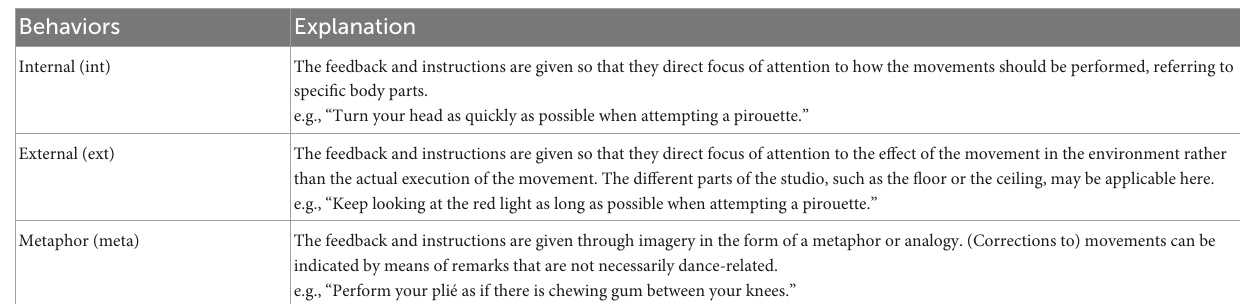
TABLE 2 Classification of focus of attention